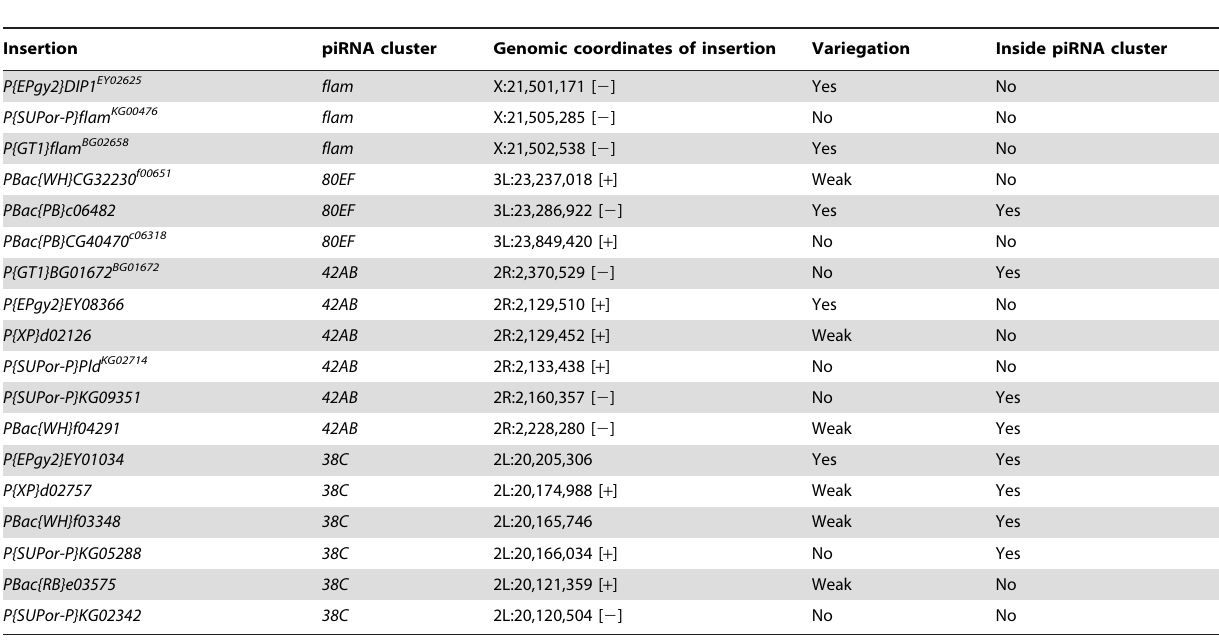
Table 1. Expression of mini-white in fly lines harboring P element insertions in four top piRNA clusters.